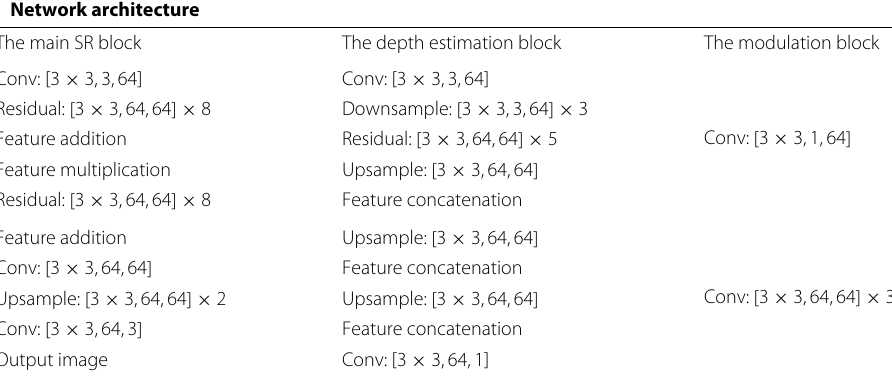
Table 1 Architectures of the proposed network including three sub-blocks Network architecture The main SR block The depth estimation